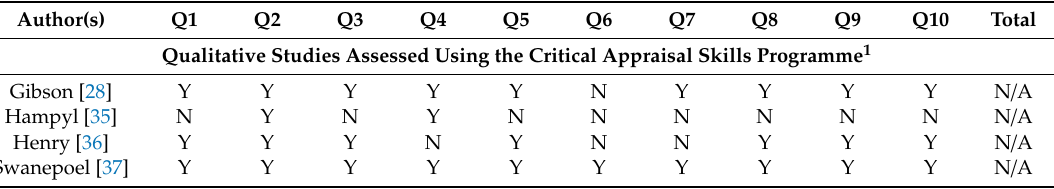
Table 3. Quality assessment of included